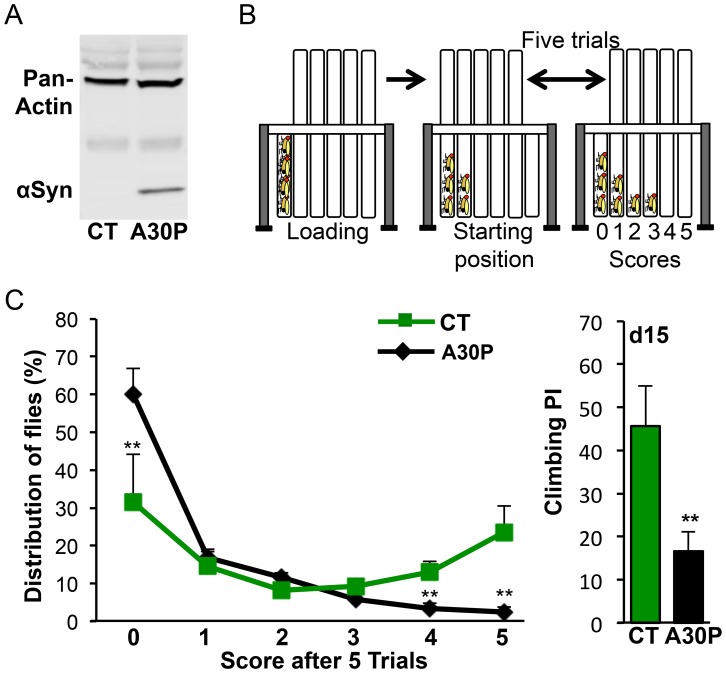
A30P flies show climbing deficit.(A) A30P expression in A30P flies. A30P protein from heads of five days old flies was probed using human-specific αSyn antibody. Pan-actin expression was used as an internal control. (B) Climbing assay. Climbing performance was measured based on negative geotaxis using countercurrent apparatus. By moving the upper five climbing tubes back and forward between each trial per test, flies would distribute between tubes 0 through 5. Each trial is 10 seconds. Details are in materials and methods. (C) Left: Fly distribution based on climbing performance. More CT flies reached the No.5 tube, while more A30P flies stayed in the No.1 tube. The percentage distribution (%) for a tube is [(# of flies in the tube)/(# of flies per test)]×100. The assays were performed with flies of fifteen days old. Fifty to eighty flies were used per trial. Ct vs. A30P: t0 (8) = 3.588, **P
0 = 0.007; t4(8) = 3.770, **P
4 = 0.0054; t5(8) = 3.846, **P
5 = 0.0049. Right: The compounded climbing performance index (PI) from the left. PI = 100%×[Σ5
i = (# of flies)i×i/(# of flies per test)×5]. t(8) = 4.768, **P = 0.0014; CT is +/+: A30P/+; A30P is Elav/+: A30P/+, hereafter unless noted otherwise. Student t-test.